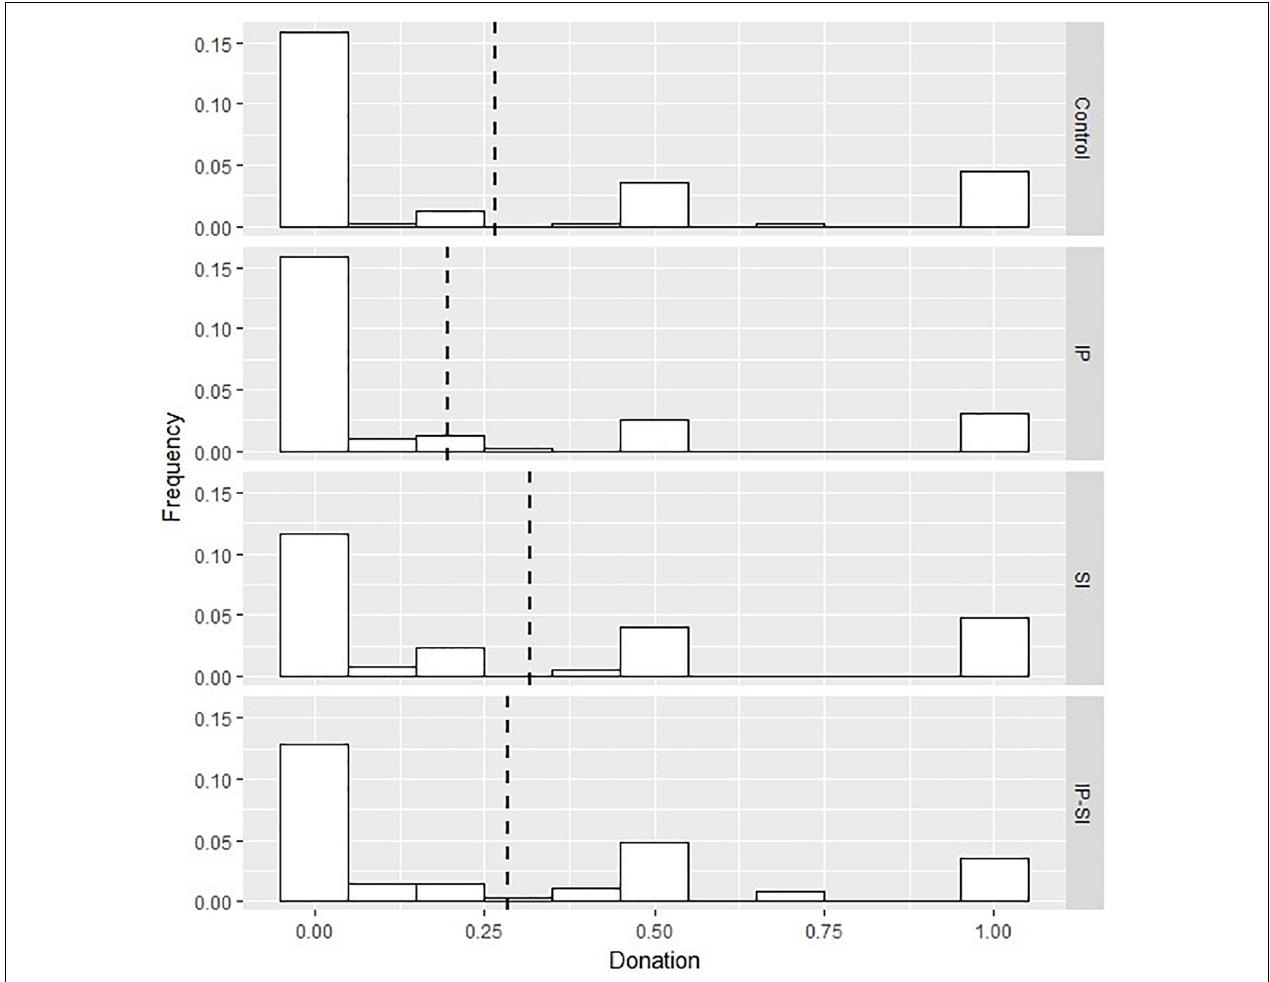
FIGURE 2 | Distribution of donation per experimental condition, Study 1. IP, identity priming; SI, social information; IP – SI, identity priming and social information. Dashed line represents mean